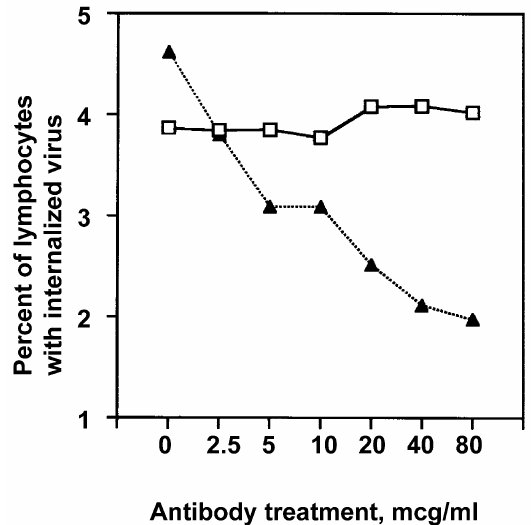
Figure 10. Flow cytometric analysis of internalization of FITC-labeled influenza virus by lymphocytes exposed in the presence of monocytes-macrophages (i.e., as PBMC). PBMC were exposed to virus after pretreatment ( (cid:78) ) or sham pretreatment (isotype control, (cid:3) ) with antibody to ICAM-1. Results are shown for lymphocytes after addition of ethidium bromide to cultures to identify internalized (versus bound)